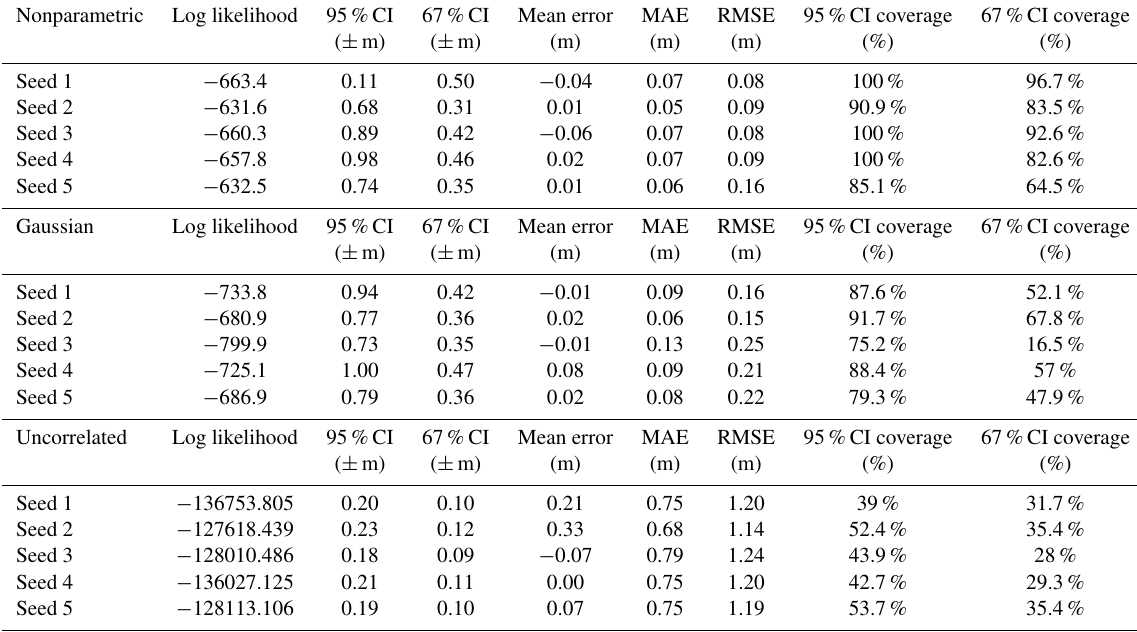
Table D2. Validation tests results: model comparison of nonparametric, Gaussian, and uncorrelated models.